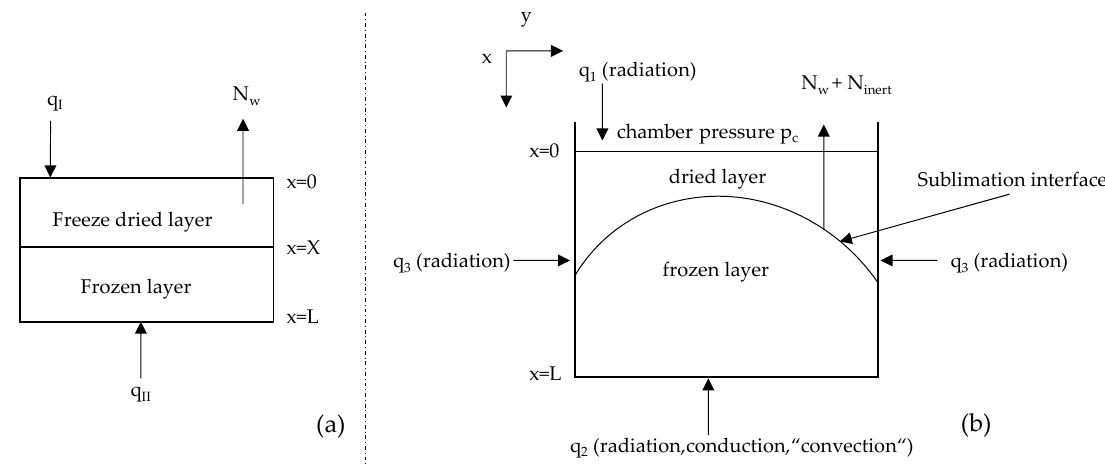
Figure 5. Schematic representation of the ( a ) one-dimensional two-phases with uniform sublimation front (adapted from [42]) and of a ( b ) two-dimensional freeze-drying model showing the sublimation interface and axial and radial heat transfer (adapted from [59]).